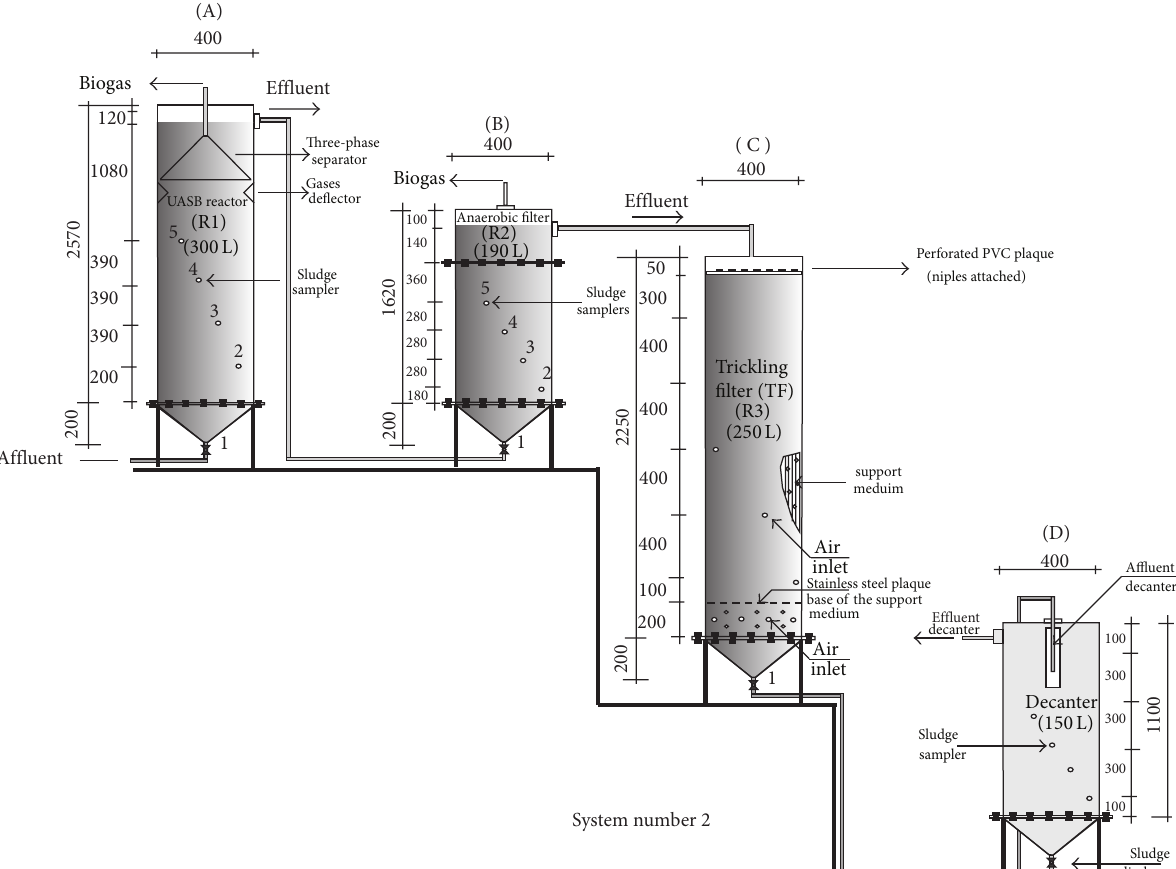
Figure 2: Experimental facility design for treatment system II consisting of UASB reactor, upflow anaerobic filter, trickling filter, and decanter placed in series, at pilot scale. Source: Duda and Oliveira